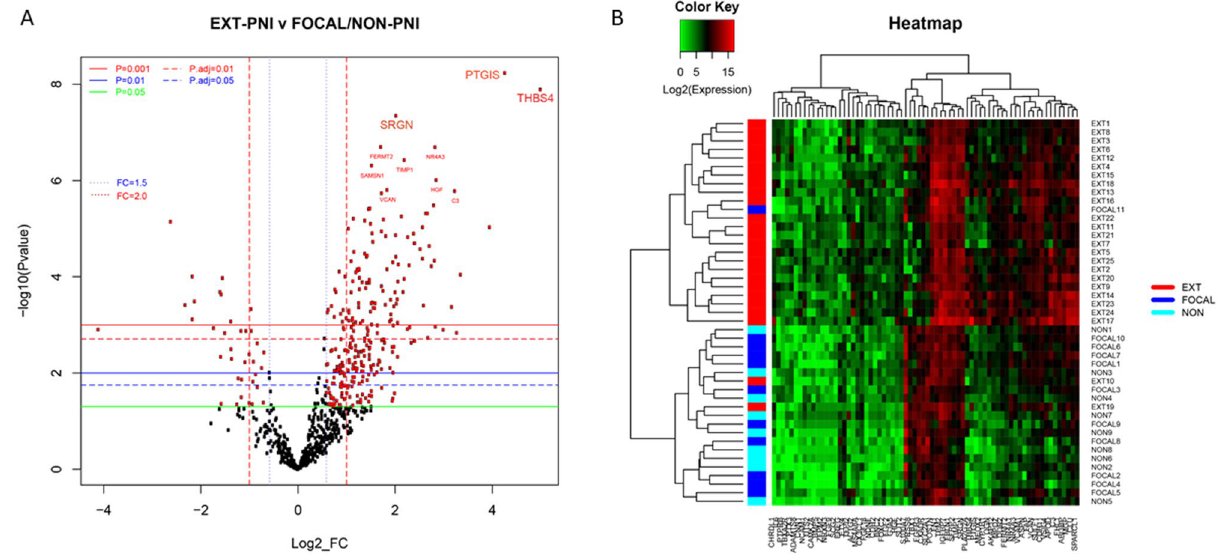
Figure 2. Differential gene expression between EXT PNI versus focal/non PNI cohorts. ( A ) Volcano plot showing each genes − log10 ( p -value) and log2 fold change (FC) of EXT-PNI compared to combined Focal/ Non-PNI cohorts. Highly statistically significant and differentially expressed genes fall at the top or to either side of the plot, respectively. Colored horizontal lines indicate various unadjusted and adjusted p -value thresholds. Vertical lines indicate FC of ± 1.5 or 2 × (FC = 1.5 and FC = 2.0). The most statistically significant genes are specifically labeled. ( B ) Heatmap of the normalized data, scaled to give all genes equal variance, generated via unsupervised clustering based on the highest ranking differentially expressed genes between EXT and Focal/ Non-PNI cohorts with fold change > 3, < − 3 and adjusted p -value < 0.01. Green represents low expression, Red represents high expression.